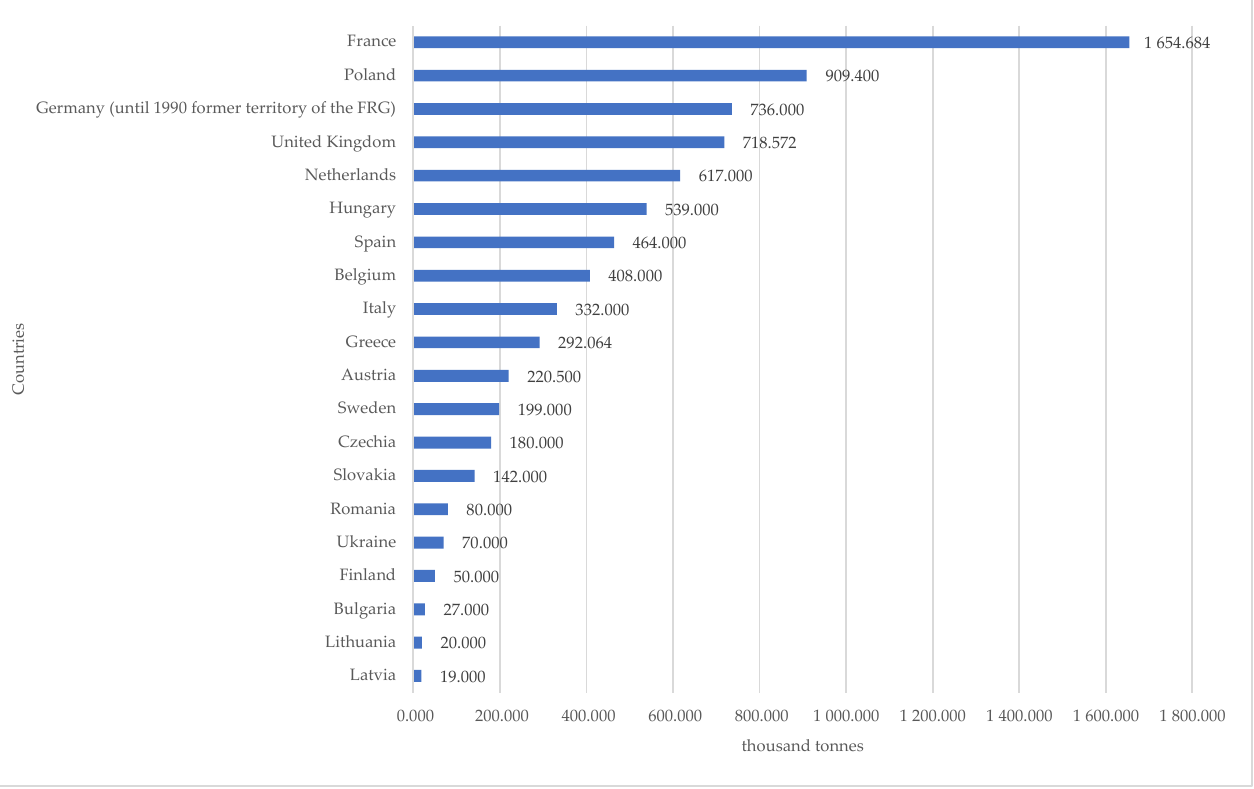
Figure 4. Pure biodiesel production in Poland in 2007 – 2019 (thousand tons). Source: own elaboration based on Eurostat data [55].